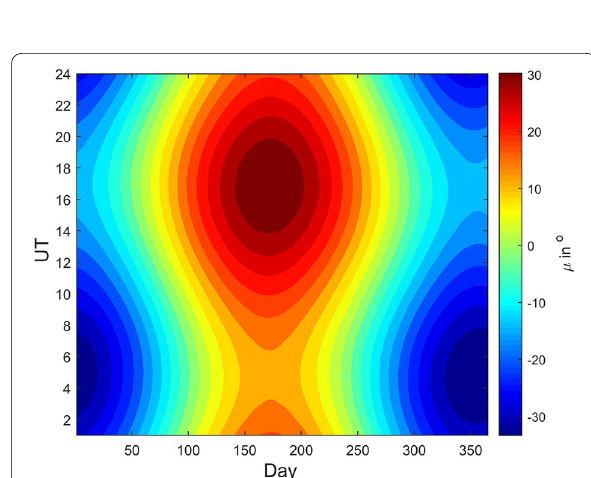
Fig. 11 Geodipole tilting angle daily and hourly variations. Daily and hourly variations of the geodipole tilting angle, computed by GEOPACK